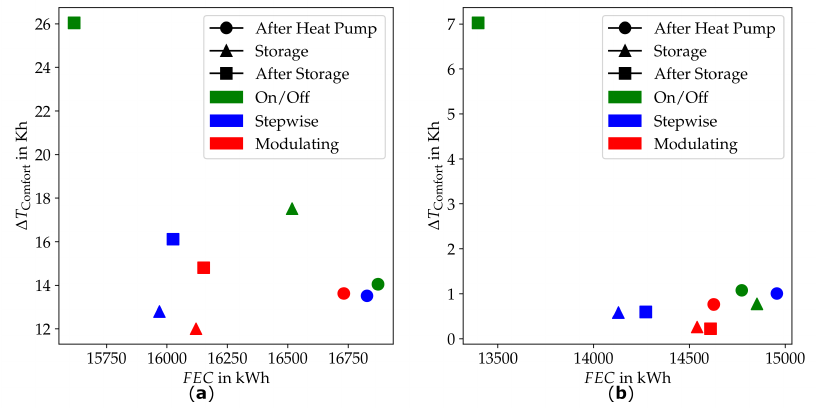
Figure 9. Thermal discomfort according to [48] versus electricity demand. For both cases, average weather and a non-refurbished building apply. ( a ) Scenario 16: High operational envelope and radiators with 75°C nominal temperature demand. ( b ) Scenario 17: Low operational envelope and radiators with 55°C nominal temperature